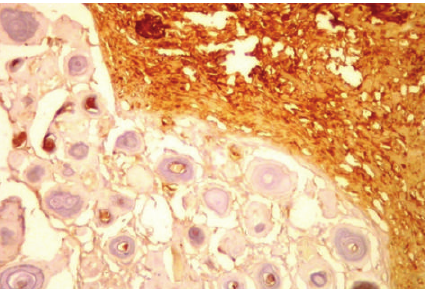
Figure3:Positiveimmunohistochemicalstainingofmeningothelial cells, epithelial membrane antigen.